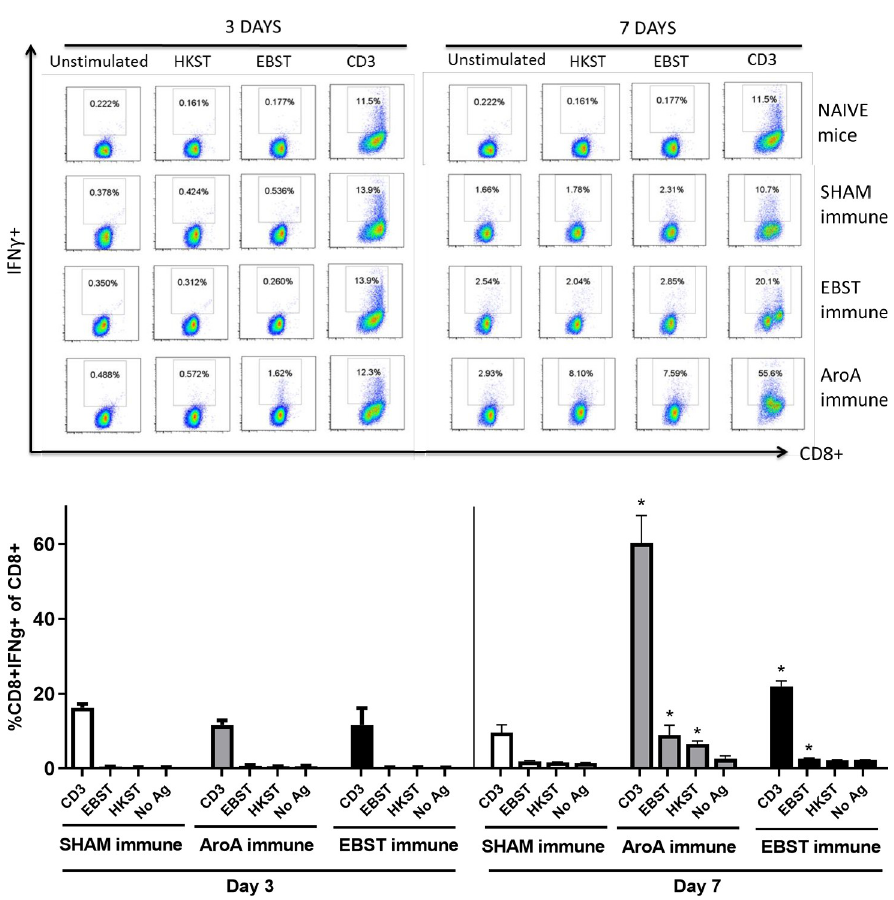
Fig 9. Salmonella specific CD8+IFN γ + T cell responses in EBST, Live ST and Sham mice during virulent ST challenge. Individual EBST immune, AroA immune, and Sham immune mice were infected with virulent ST and at 3 days and 7 days post infection splenocytes were measured for production of IFN γ by antigen specific CD8+ T cells using intracellular cytokine staining (ICS).Antigens used were EBST and HKST (2 x10 7 cells/ well) and anti-CD3 antibody as positive control. Unstimulated splenocytes were included as control. Percentages in the gated region of dot plots indicate the proportion of CD8+IFN γ + of total CD8+ splenocytes (Fig 9A). The data represents three-five individual mice per group. The bar graphs represents mean ± SEM of 3–5 mice per group. Y axis represents percentage of CD8+IFN γ + of total CD8+ splenocytes (Fig 9B) on days 3 and 7. Statistics were determined for comparisons between group for each antigen at the indicated day. � , p �